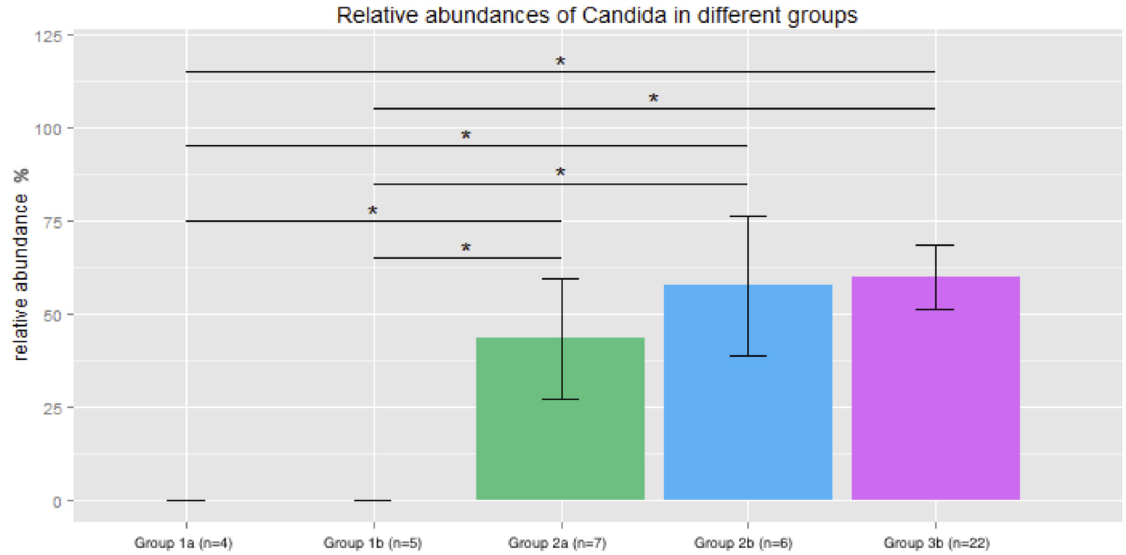
Fig 3. Average relative Candida abundance in lower respiratory tract samples. Healthy adults (bar group 1a), patients with healthy respiratory tract but with antibiotic therapy for extrapulmonary infection (bar group 1b), non-neutropenic intubated and mechanically ventilated ICU patients without antibiotic therapy (bar group 2a), non-neutropenic intubated and mechanically ventilated ICU patients with antibiotic therapy for extrapulmonary infection (bar group 2b), and patients with antibiotic therapy due to pneumonia (bar group 3b). Significant differences of average relative Candida abundance between groups are shown with bars representing the average Candida abundance and standard errors in given groups ( * = p < 0.05 for groups 2a, 2b, 3b versus 1a or